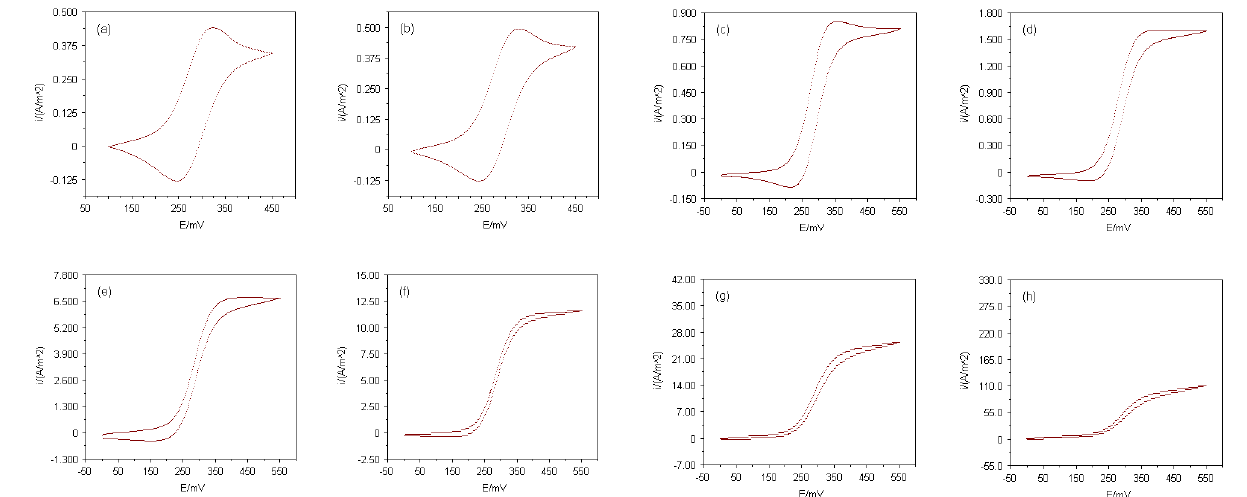
Figure 2. Cyclic voltammograms for oxidation of 400 µ M FMCA in 50mM phosphate buffer (pH 7.0) at Multi MEAs and microdisks with diameters of (a) 1000 µ m, (b) 500 µ m, (c) 100 µ m,